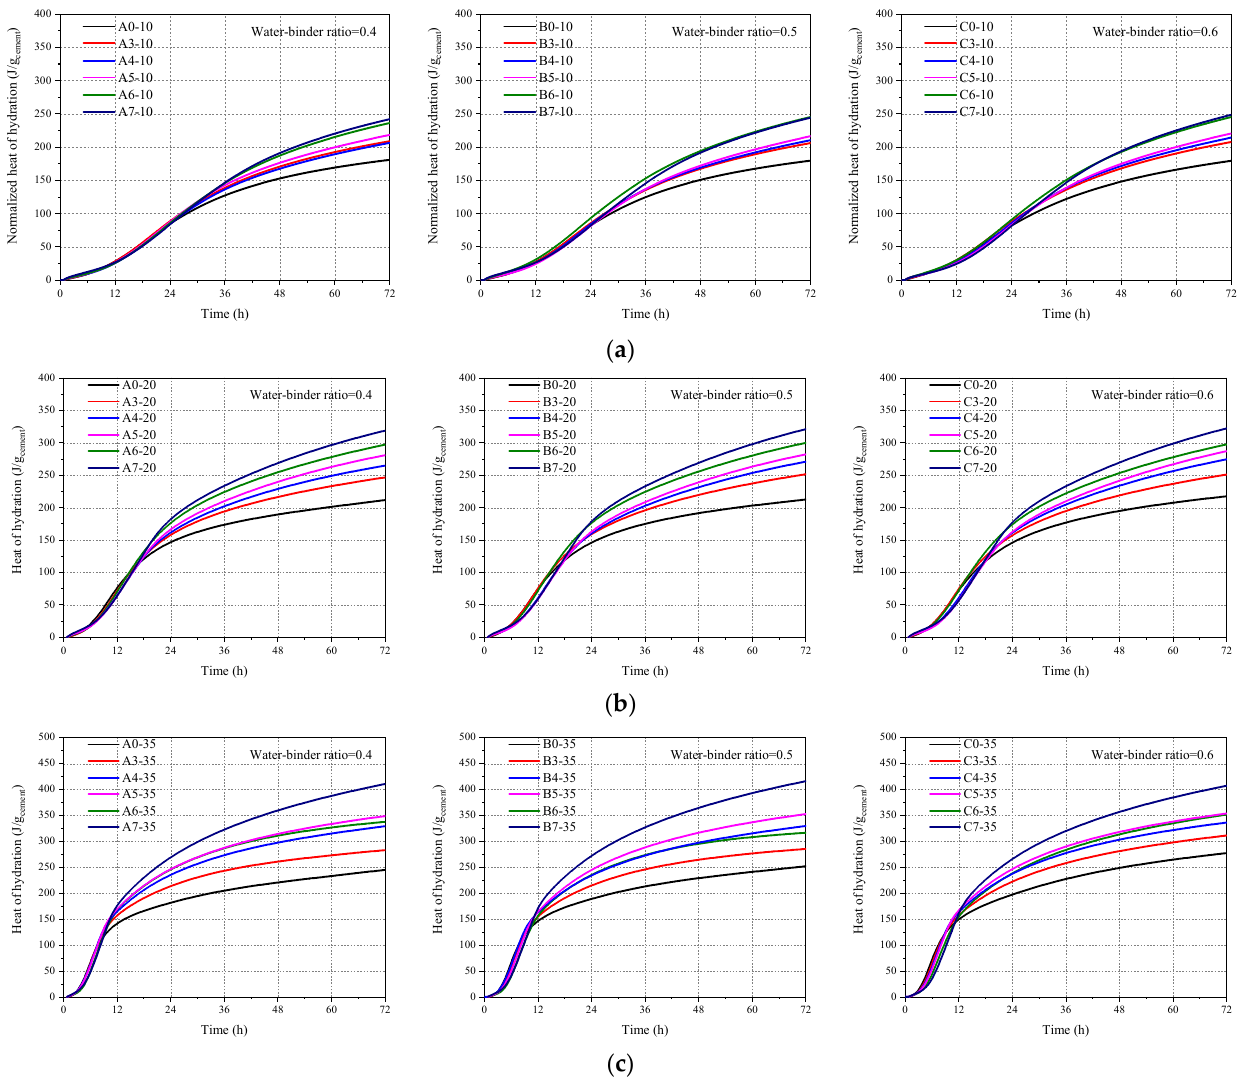
Figure 7. Cumulative heat release of the paste at different temperatures (normalized to cement). ( a ) cumulative heat release of the paste at 10 °C; ( b ) cumulative heat release of the paste at 20 °C; ( c ) cumulative heat release of the paste at 35 °C.